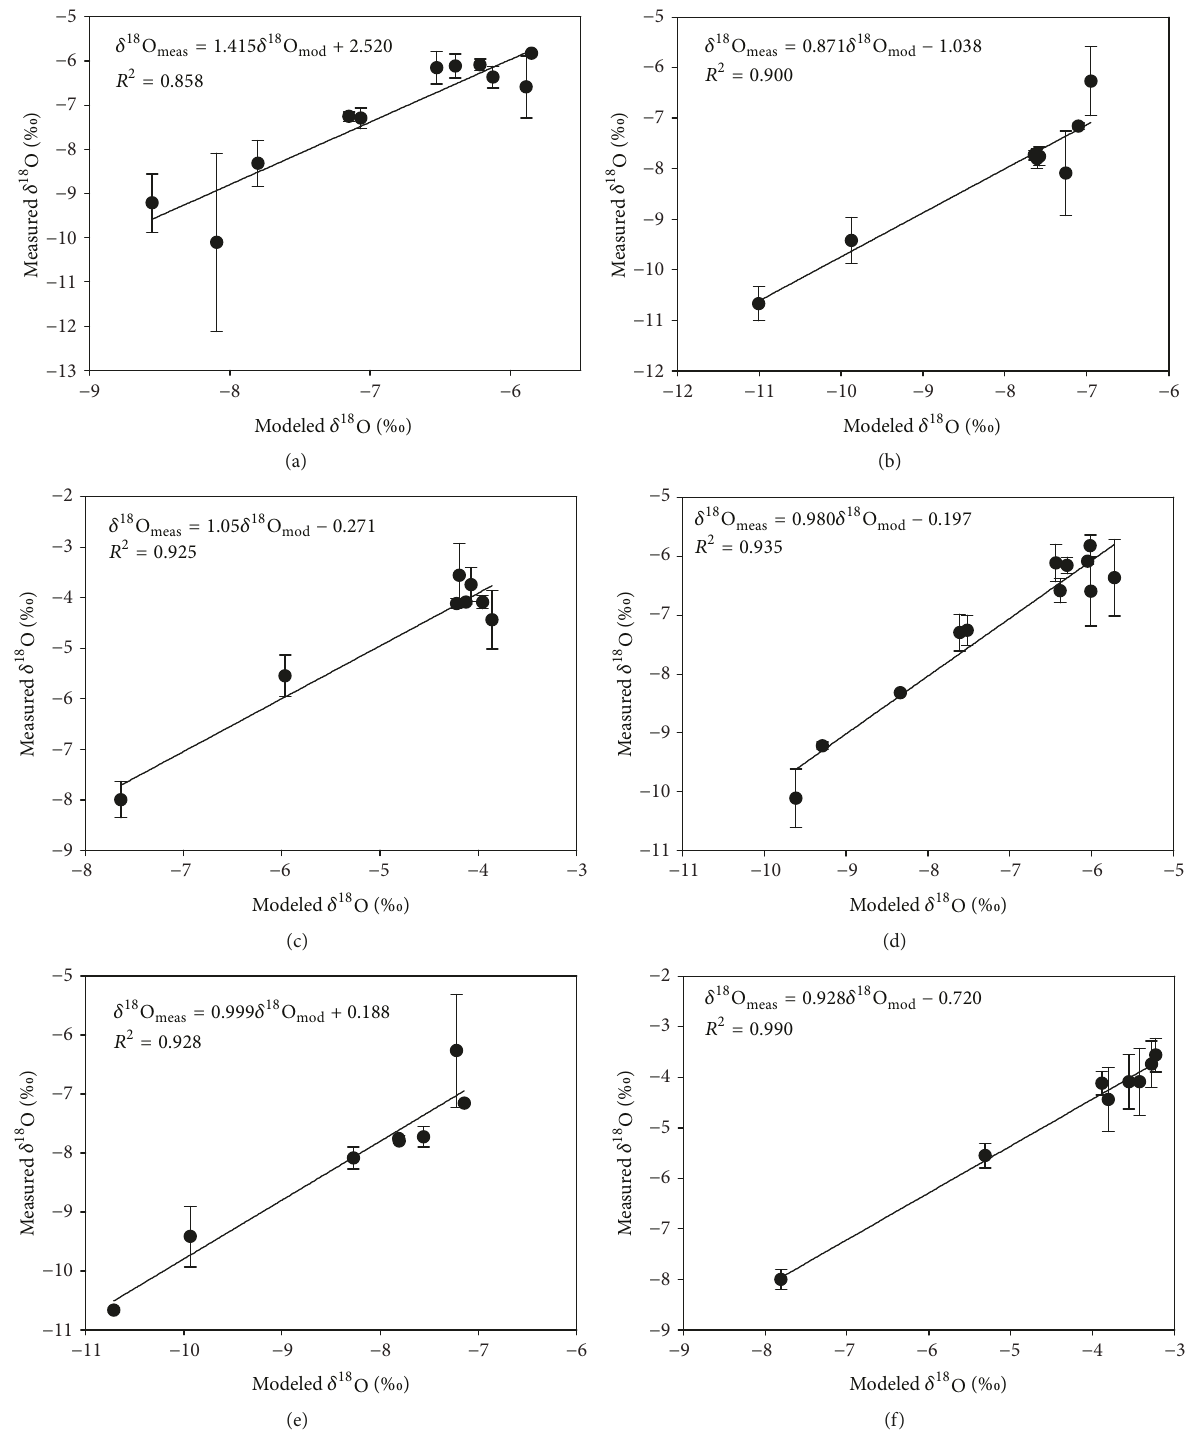
Figure 8: Linear correlations between measured amount-weighted precipitation 𝛿 18 O and modeled weighted precipitation 𝛿 18 O. Note: (a), (b), and (c) represent (5), (6), and (7) by the Bowen and Wilkinson model, respectively; (d), (e), and (f) represent (8), (9), and (10) by the linear regression model,